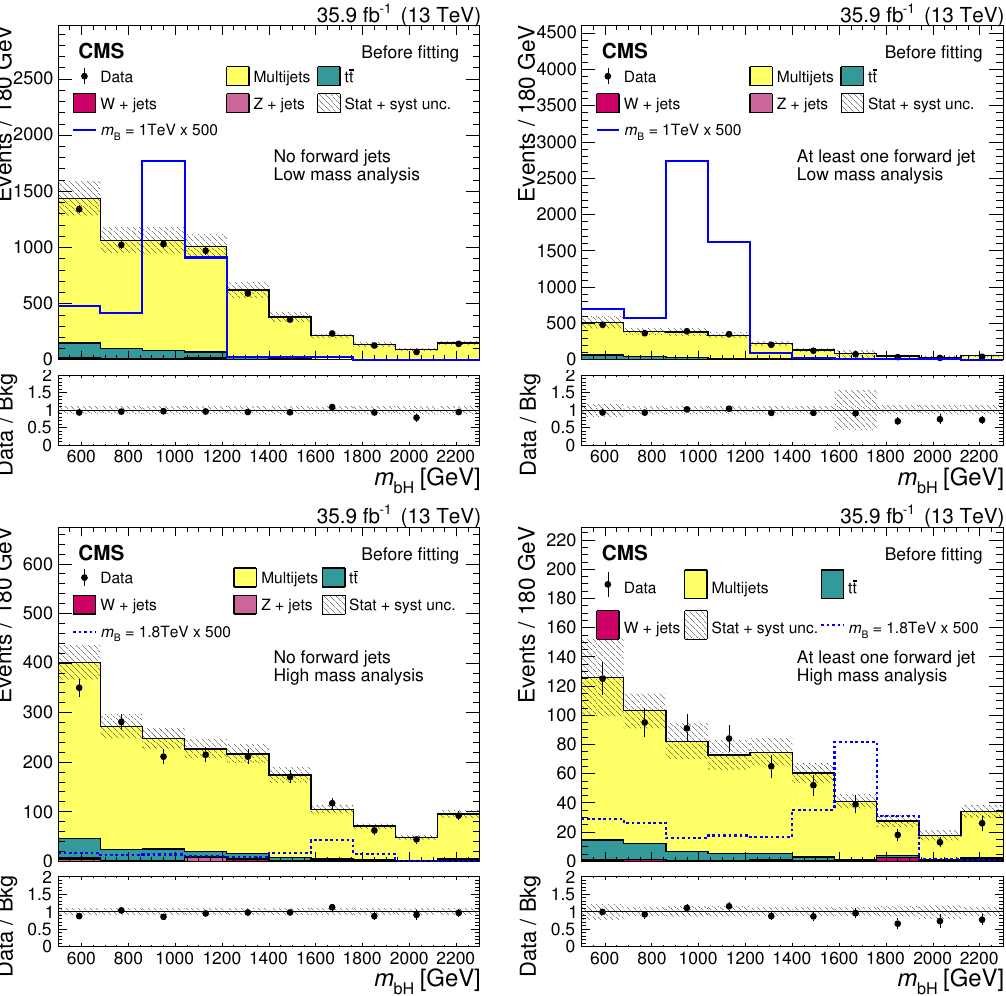
Figure 4. Distribution in the reconstructed B quark mass, after applying all selections to events with no forward jets (left) and to events with at least one forward jet (right), compared to the background distributions estimated before (cid:12)tting. The upper and lower plots refer to the low- and high-mass m B analyses, respectively. The expectations for signal MC events are given by the blue histogram lines. The di(cid:11)erent background contributions are indicated by the colour-(cid:12)lled histograms, and are obtained from Monte Carlo simulation, except for the multijets component, which is derived from data. The grey-hatched error band shows total uncertainties in the background expectation. The ratios of observations to background expectations are given in the lower panels, together with the total uncertainties prior to (cid:12)tting, indicated by the grey-hatched band.